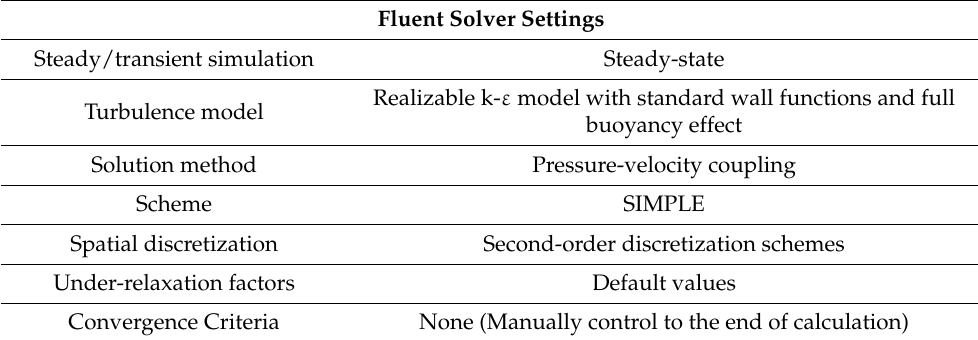
Table 3. The Fluent solver settings used the in